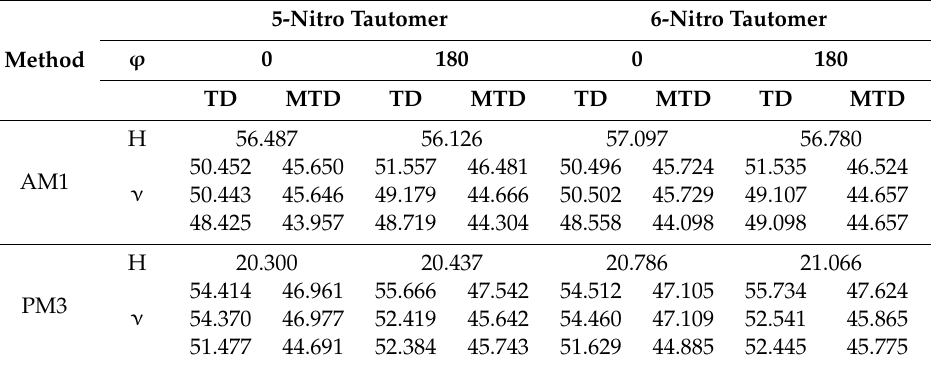
Table 3. The formation heats (H, kcal / mol) of the conformers A and C of 2-trichloromethyl-5(6)- nitrobenzimidazole and 35 Cl NQR frequencies ( v , MHz), obtained from Townes–Dailey (TD) and modified Townes–Dailey (MTD) equations